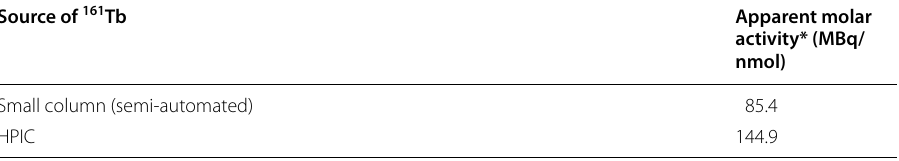
Table 4 Comparison of highest achievable apparent molar activity for [ 161 Tb]Tb-crown-αMSH synthesized from both the small column and HPIC purified 161